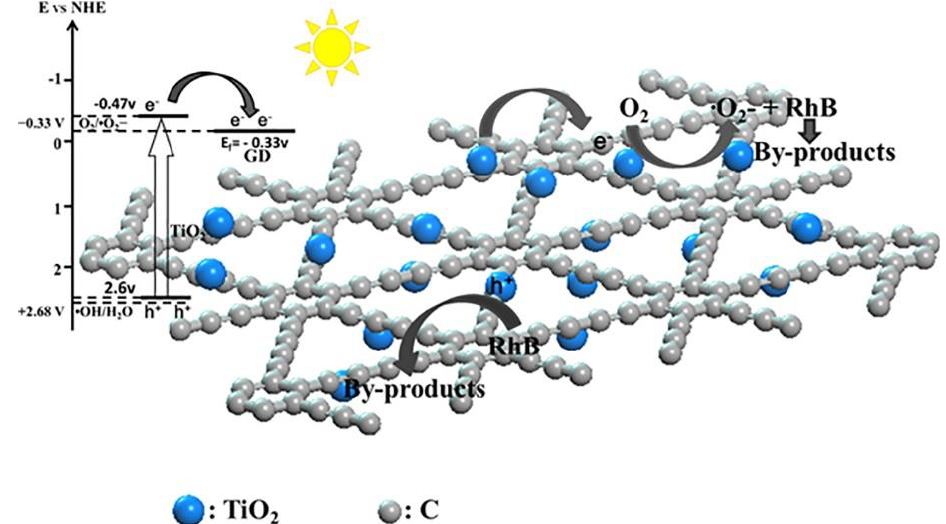
Figure 9. Schematic illustration for the possible mechanism of the visible light-driven photocatalytic degradation for the GD-NTNS composites. Reprinted with permission from [86]. Copyright 2018, Springer.